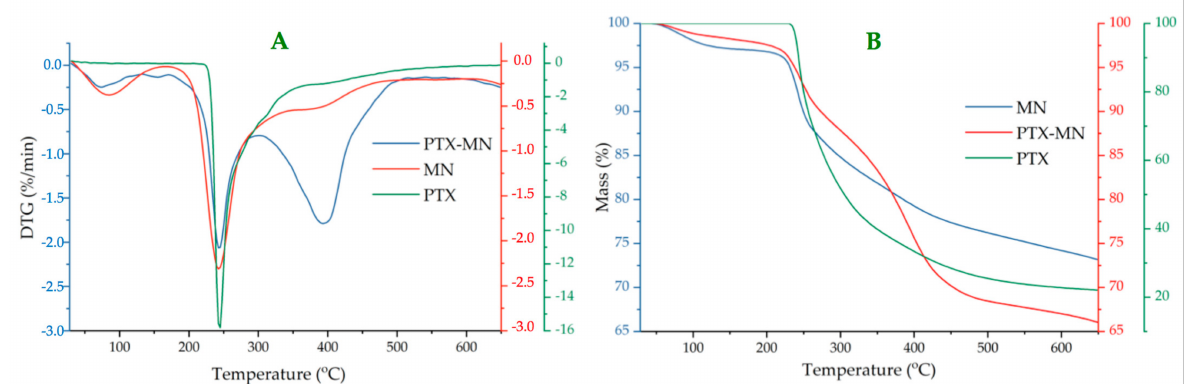
Figure 4. DTG ( A ) and TG ( B ) curves of PTX, PTX-MN nanoparticles and drug-free MN